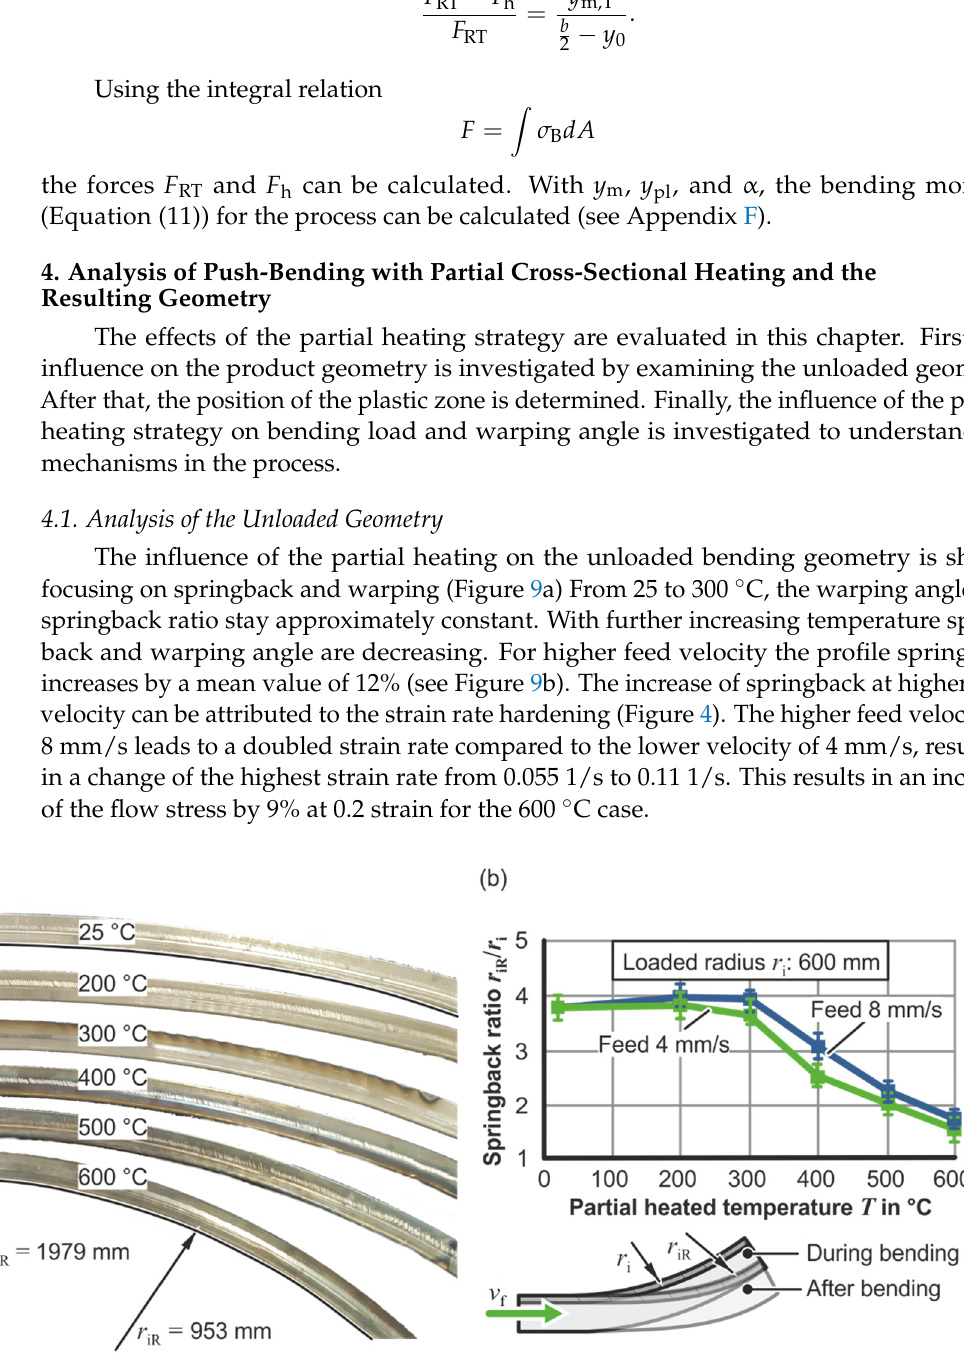
Figure 9. ( a ) Profile specimens and corresponding cross-sections for a 600 mm loaded bending radius (change of moment arm through the heating area is neglected) and profile feed of 8 mm/s for different temperatures in the sprung back state. ( b ) springback ratio for varying partial heating temperatures and profile feed velocities.